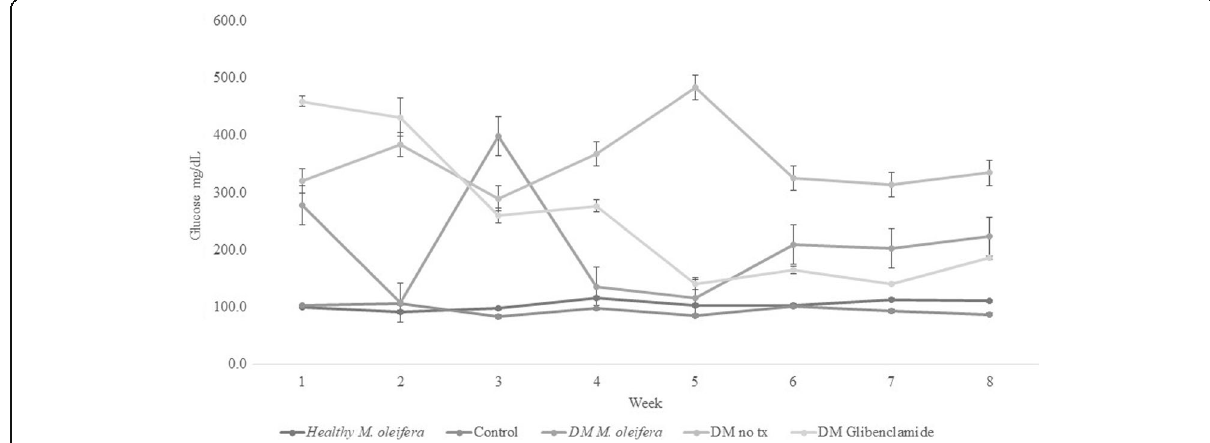
Fig. 4 Glucose values (mg/dL) in study groups during experiment. Data are expressed as mean ± error standard per